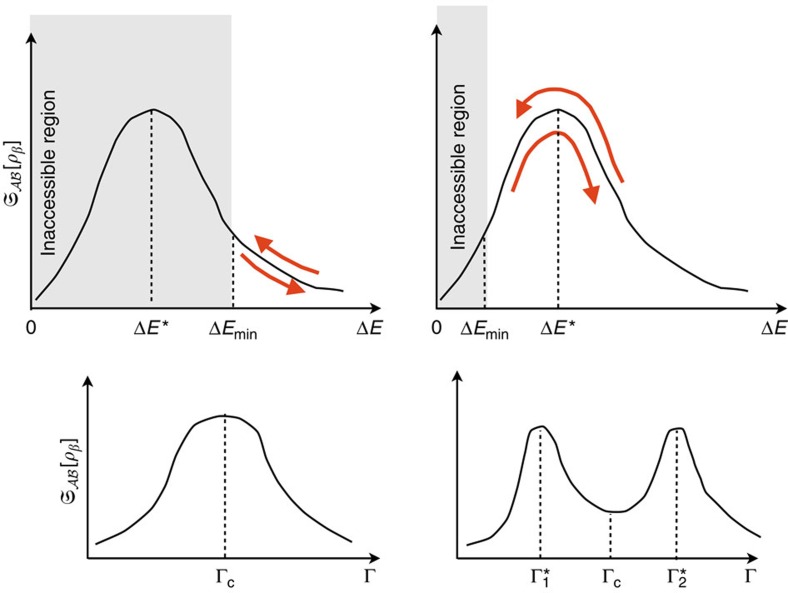
Heat capacity in the Landau–Zener model.The emergence of extremal points in the behaviour of  as a function of increasing control parameter Γ is associated to the relative size of ΔEmin with respect to ΔE*. The red arrows denote the changing of ΔE during a typical Landau–Zener protocol. One realizes that, if ΔEmin>ΔE* one peak will appear (left), whereas if ΔEmin<ΔE* two peaks will appear (right).